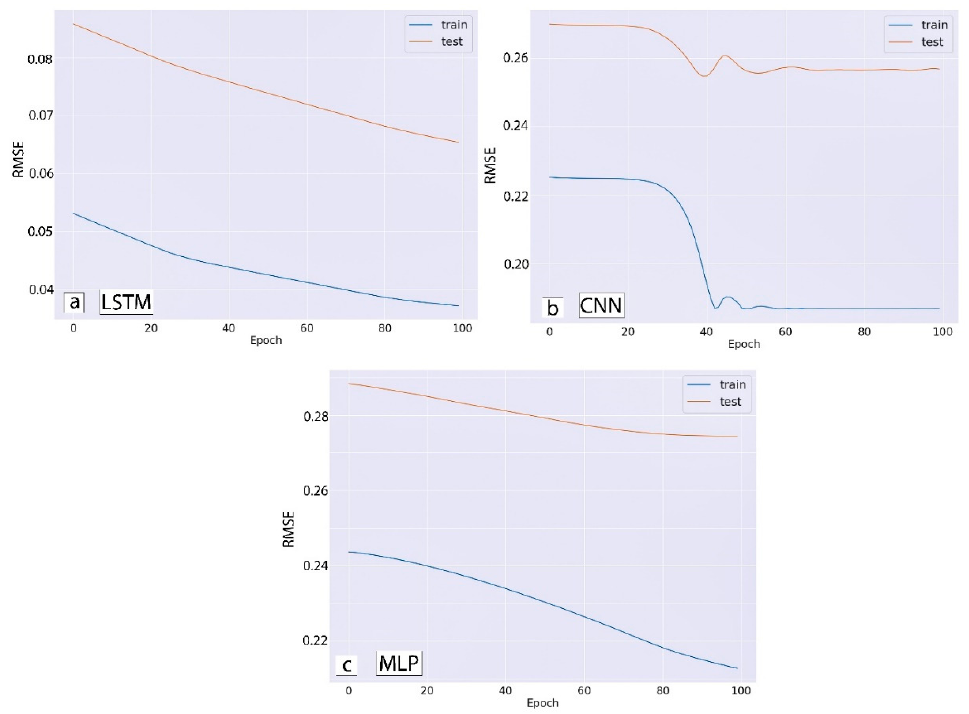
Figure 11. Model performance improvement with an increase in the number of Epoch for both the train and test datasets. RMSE of the normalized values decreases with the inclusion of more epochs or iterations. ( a ) LSTM model; ( b ) CNN model; ( c ) MLP